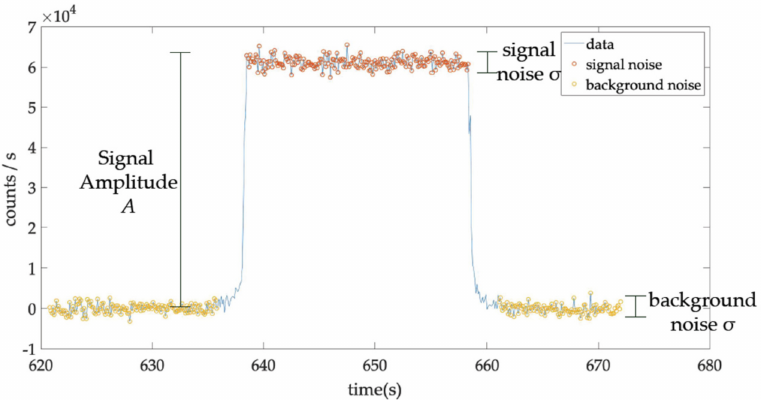
Figure 2. Illustration of the noise in the background and noise in the signal.